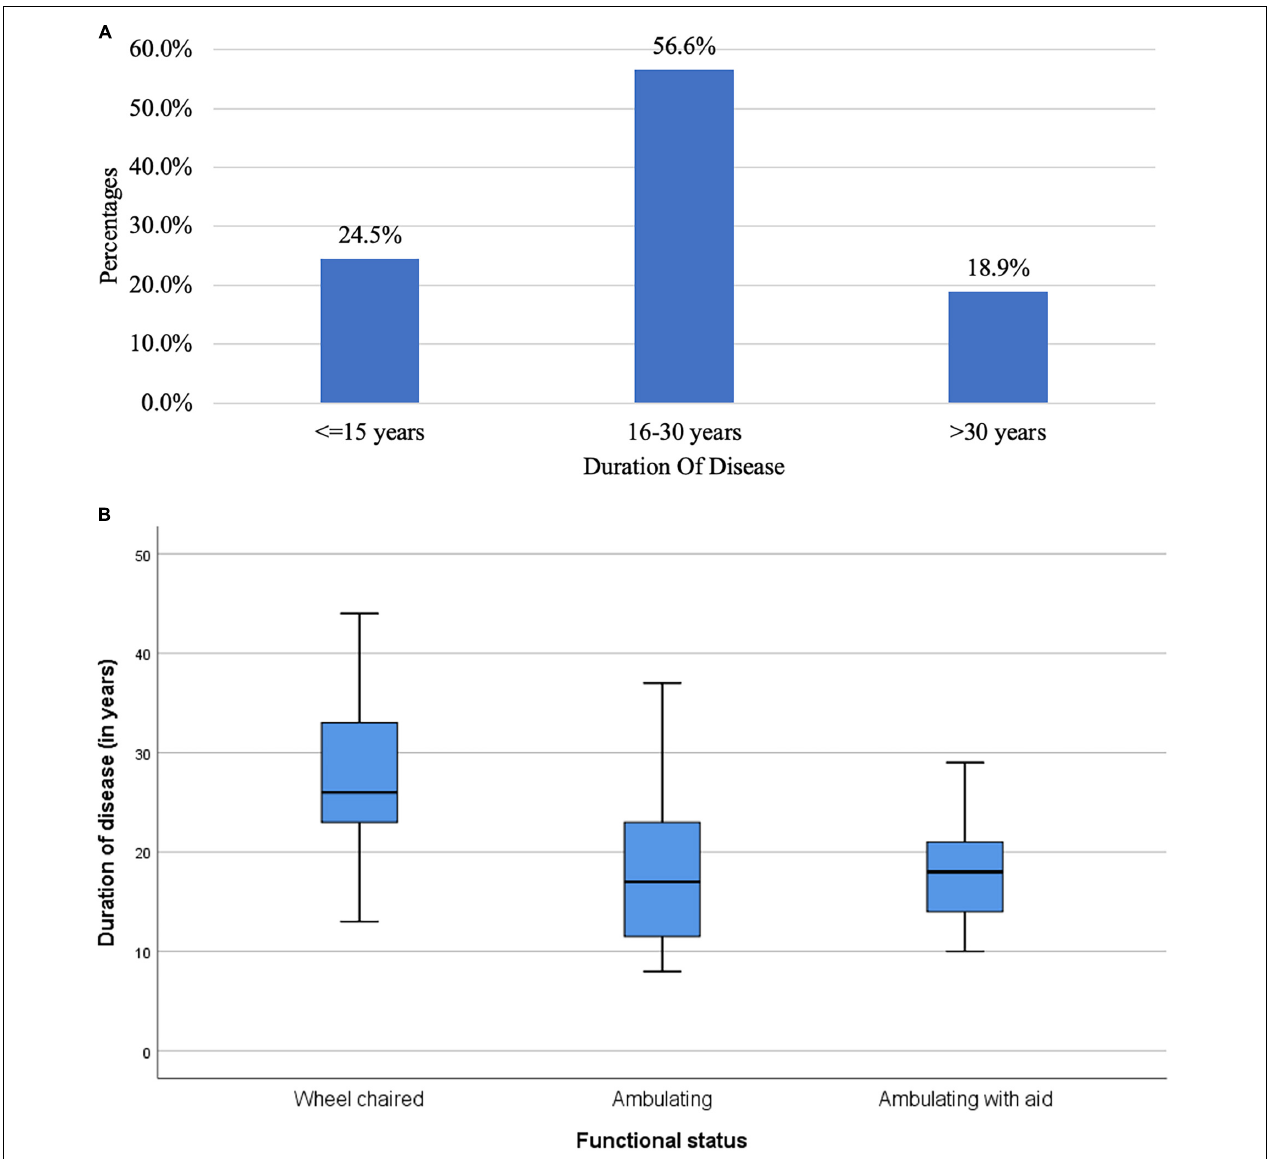
FIGURE 3 | (A) Bar chart of duration of disease in the study population ( N = 53). (B) Box plot for distribution of duration of disease across function status ( N =